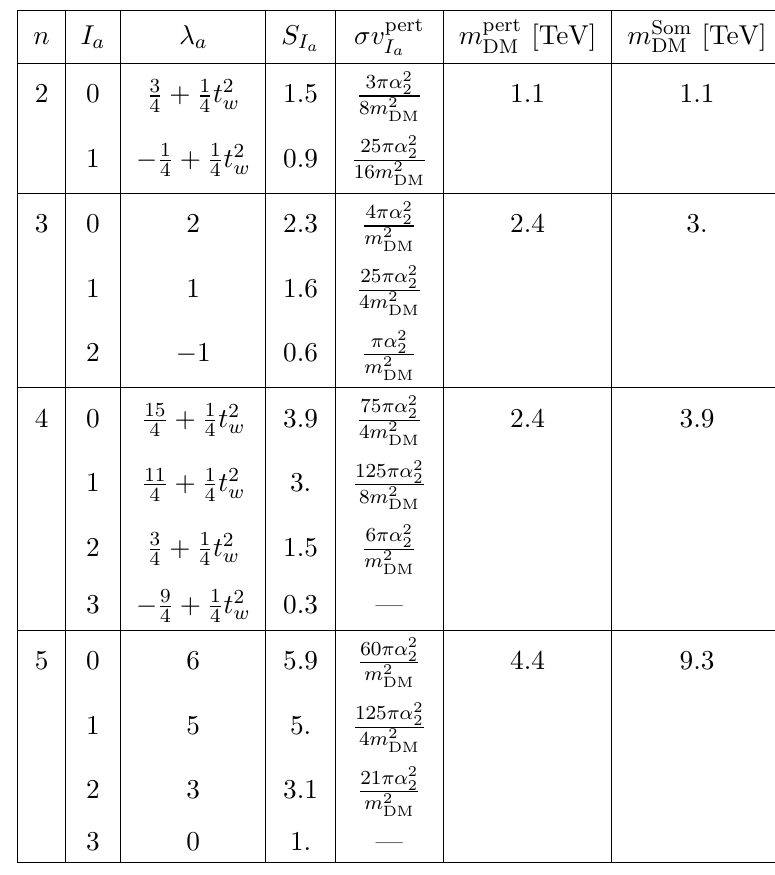
Table 3. For the pure multiplet of dimension n , the Isospins of the relevant 2-particle states are given by I a , the potentials are driven by the (cid:21) a = together with the appropriate (cid:27)v pert matter mass including Sommerfeld corrections only in the SU(2) L symmetric limit ( m pert without Sommerfeld